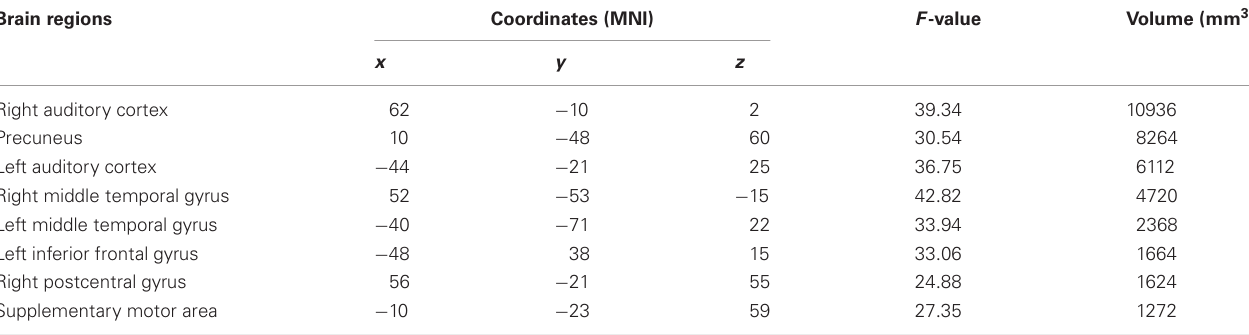
Table A2 | Activated clusters involved in the correlation between local-to-global ratio BP ND (white matter as reference region) (in visual cortex) and the difference of FC (EC-EO) (visual cortex as seed